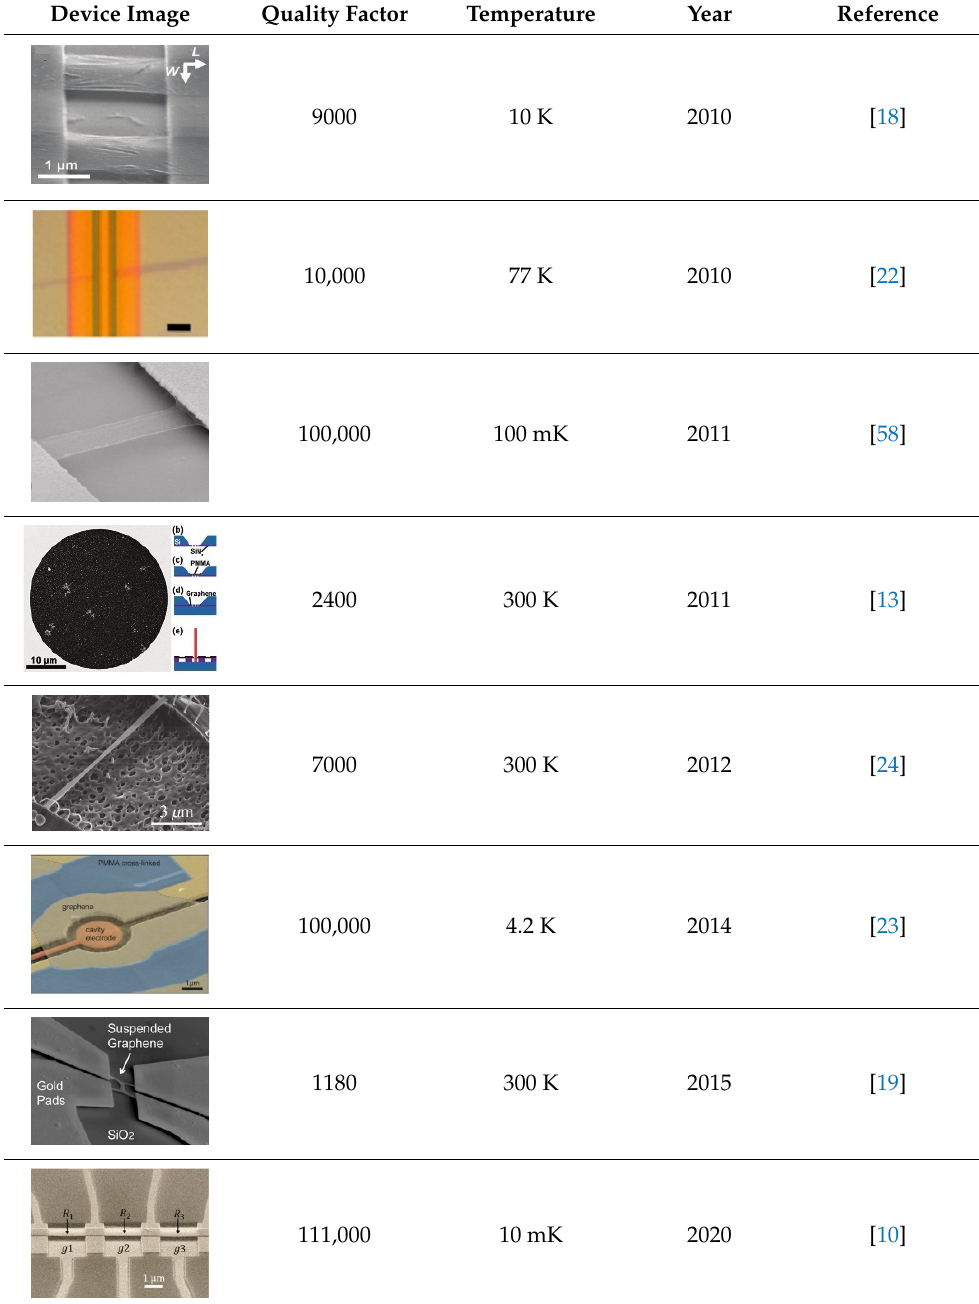
Table 1. The quality factors of different graphene resonators.